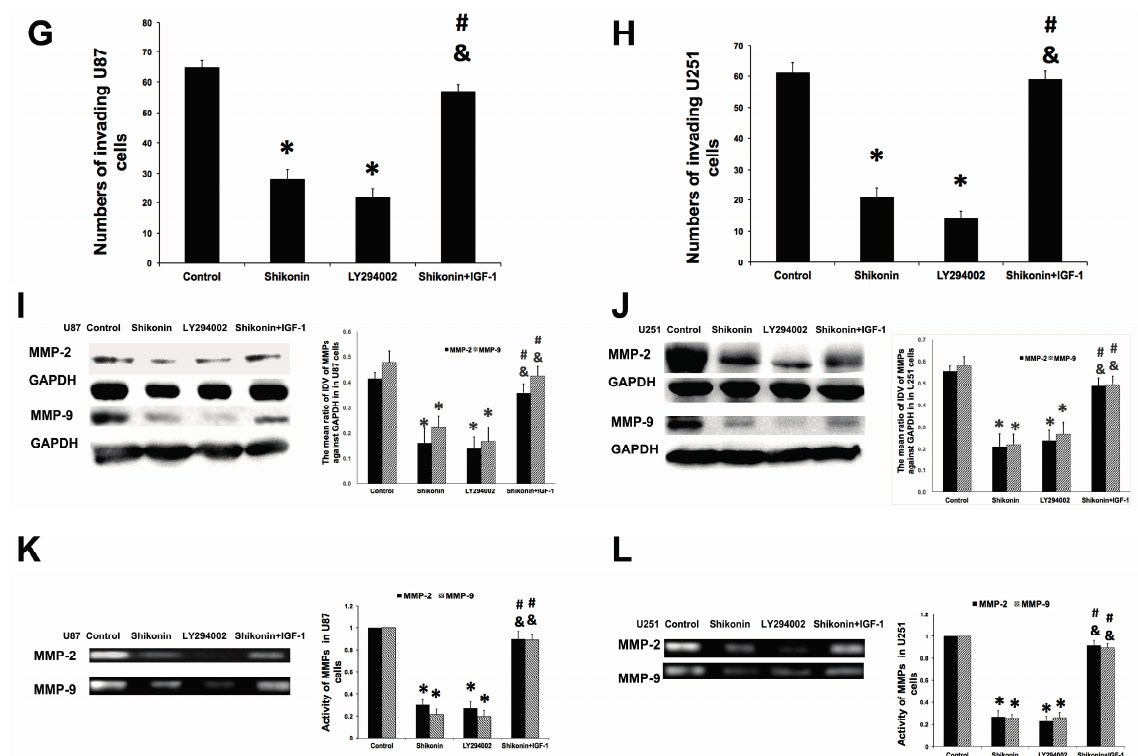
Figure 8. The effects of PI3K/Akt inhibitor or agonist on the migration, invasion, and MMP expression and activity of glioma cells. U87 and U251 cell were treated with shikonin (5 μ mol/L), PI3K/Akt inhibitor LY294002 (20 μ mol/L), or shikonin combined with the PI3K/Akt agonist IGF-1 (20 μ g/mL). Shikonin and LY294002 attenuated the migration, invasion, and MMP expression and activity in both cell lines compared with the control group. Treatment of IGF-1 compensated for the inhibitory effects of shikonin compared with either the shikonin or LY294002 group, indicating that activation of PI3K/Akt could reverse shikonin-induced inhibition. These results showed that PI3K/Akt might also be a target in the process. ( A ) Results of Transwell in vitro migration assay in U87 cells; ( B ) Results of Transwell in vitro migration assay in U251 cells; ( C ) Statistical analysis of in vitro migration assay for U87 cells; ( D ) Statistical analysis of in vitro migration assay for U251 cells; ( E ) Results of in vitro invasion assay in U87 cells; ( F ) Results of in vitro invasion assay in U251 cells. IGF-1 reversed the shikonin-induced inhibition; ( G ) Statistical analysis of in vitro invasion assay for U87 cells; ( H ) Statistical analysis of in vitro invasion assay for U251 cells; ( I ) Western blot results of MMP-2 and MMP-9 in U87 cells; ( J ) Western blot results of MMP-2 and MMP-9 in U251 cells; ( K ) Results of zymography in U87 cells. Shikonin and LY294002 significantly inhibited the activity of MMP-2 and MMP-9 in U87 cells, which could be reversed by IGF-1; ( L ) Results of zymography in U251 cells. * p < 0.01, compared with the control; # p < 0.05 compared with the shikonin group; & p < 0.05 compared with the LY294002 group ( n = 3). Bar stands for 50 μ m. Original magnification of A , B and E , F :